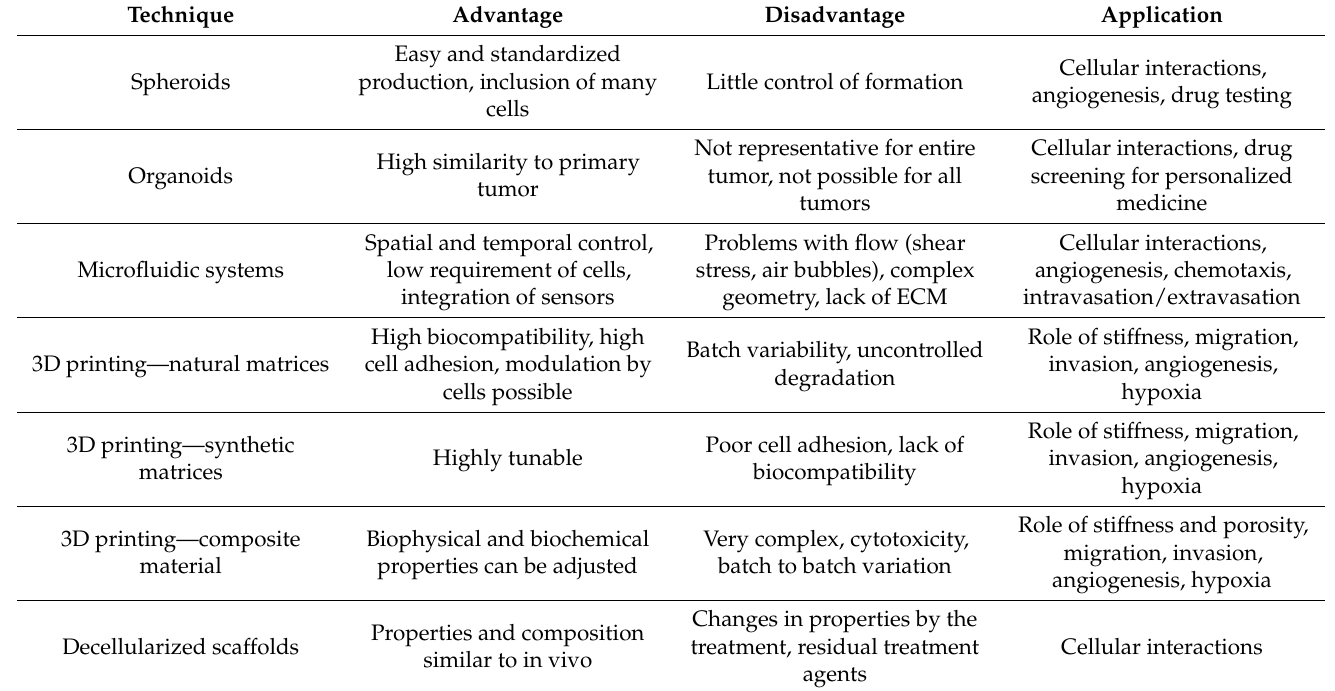
Table 1. Overview of advantages, disadvantages and main applications of 3D BC